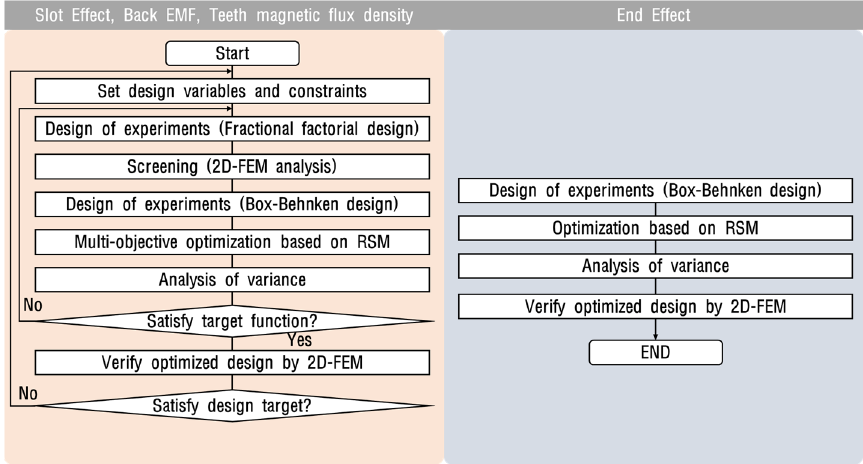
Figure 6. Optimization process flow chart. Table 2. Design variables and boundary of the stator and the mover. Item Lower Bound Reference Upper Bound Height of PM, P h (mm)